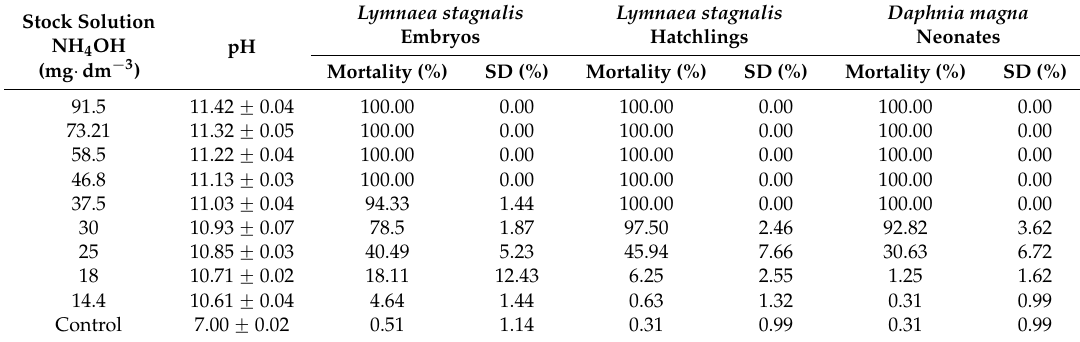
Table 4. Mortality of tested organisms in an ammonium hydroxide (24 h) (AVG ˘ SD). Stock Solution NH 4